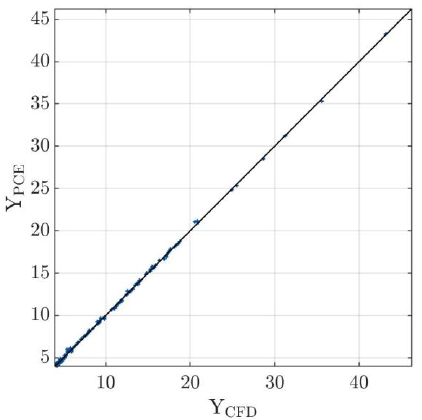
Figure 6. Regression between PCE and CFD predictions for metamodel M 2 .